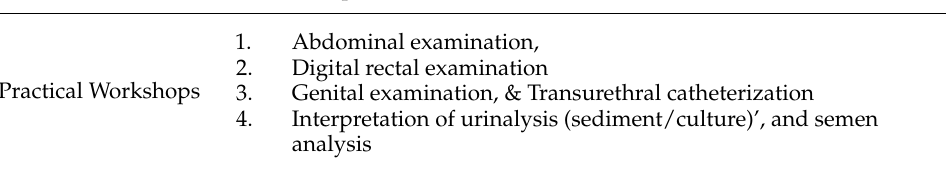
Figure 3. Evaluation of the relevance of urological pathology.